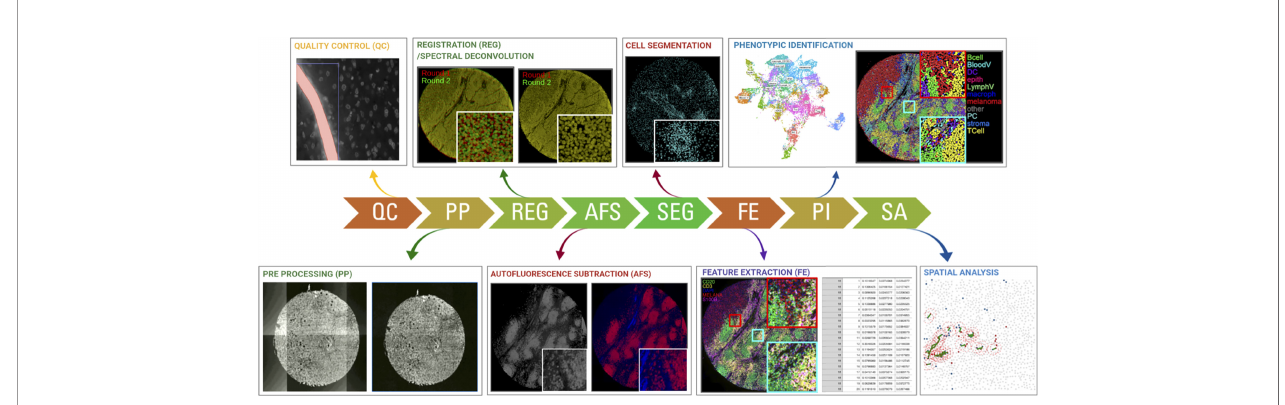
FIGURE 2 | Schematic overview of the required steps for downstream image analysis using the most commonly used fl uorescent, cyclic methods for multiplexed IHC. Images are collected across multiple cycles but still need to be cleaned (QC), corrected (PP), registered/aligned (REG), auto fl uorescence removed (AF), segmented (SEG), feature extracted (FE), phenotypically annotated (PI), and spatially resolved